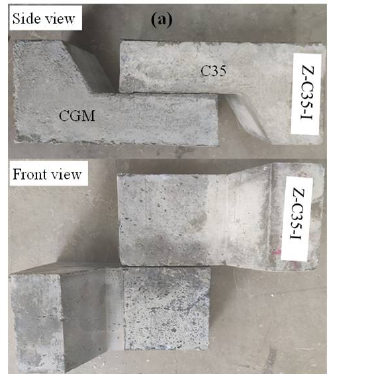
Figure 5. Typical failure modes of direct shear specimens: ( a ) pure interfacial failure; ( b ) interfacial failure with partial concrete substrate and CGM failure.